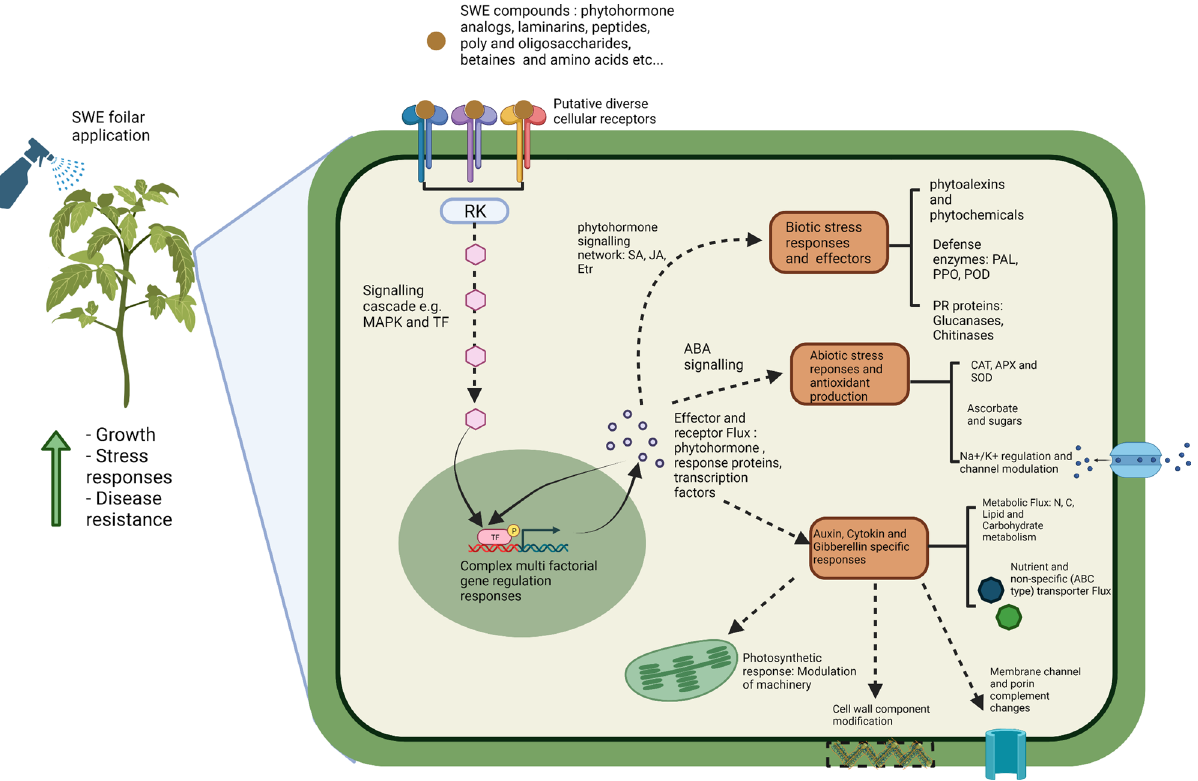
Figure 4. Visual representation of the key impacts of AN-SWE on the tomato transcriptome. The picture was created with